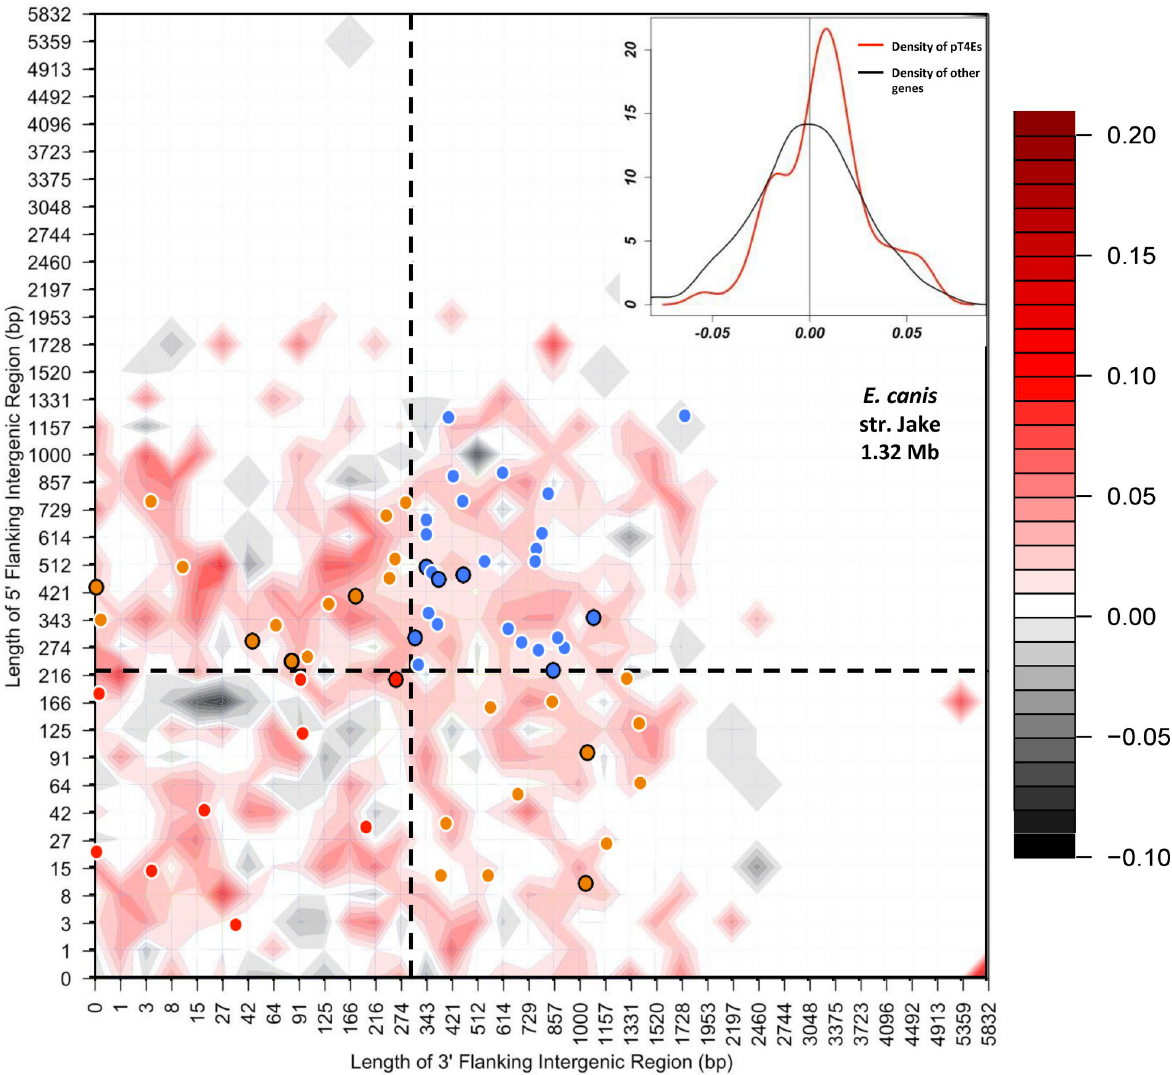
Fig 6. The distribution of Ehrlichia type IV effectomes according to local gene density and Δ GC content shows an enrichment of pT4Es in high GC content regions. Distribution of E . canis str. Jake genes according to the length of their flanking intergenic regions (FIRs). All E . canis genes were sorted in two-dimensional bins according to the length of their 5 0 ( y -axis) and 3 0 ( x -axis) FIR lengths. For each gene, the Δ GC content was calculated by subtracting the GC content of a gene by the average of GC content of all the genes. The mean of Δ GC of genes in the bins is represented by a colour-coded density graph. GSR, GDR and IBR were defined as described for the analysis of local gene density. A colour was assigned to each of the three following groups: red to GDRs, orange to IBRs, and blue to GSRs. Specific pT4Es are represented with a dot circled in black. In the top right corner, a density graph indicates the density of pT4Es according to Δ GC content (red line) and the density of other genes (black line).